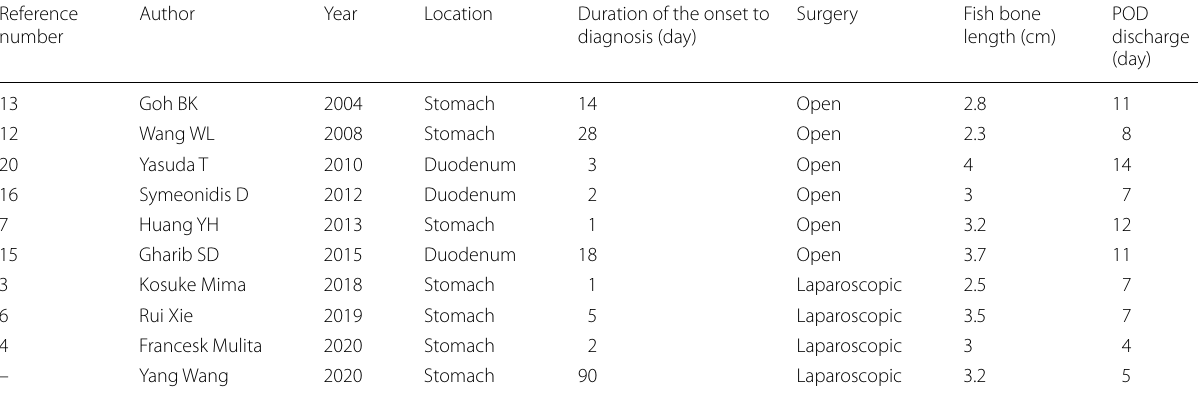
POD postoperative